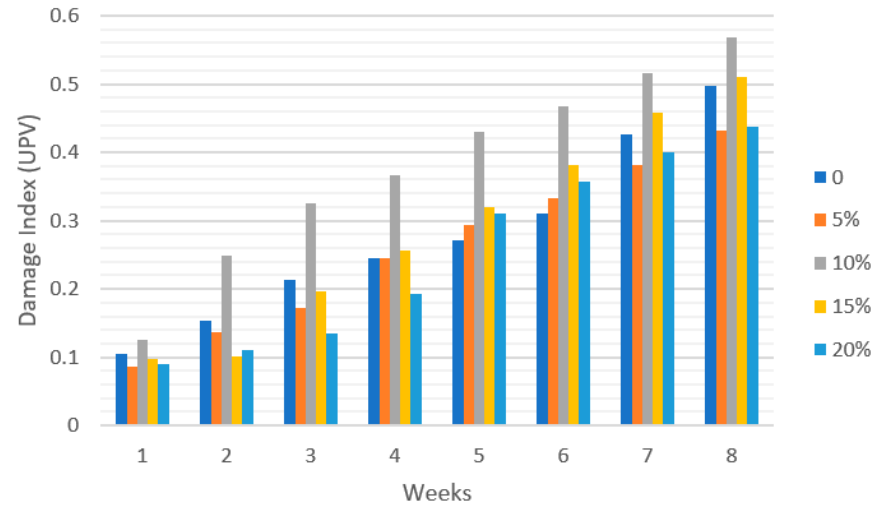
Figure 9. Damage index versus FT cycles for AC with bentonite content variation (%).